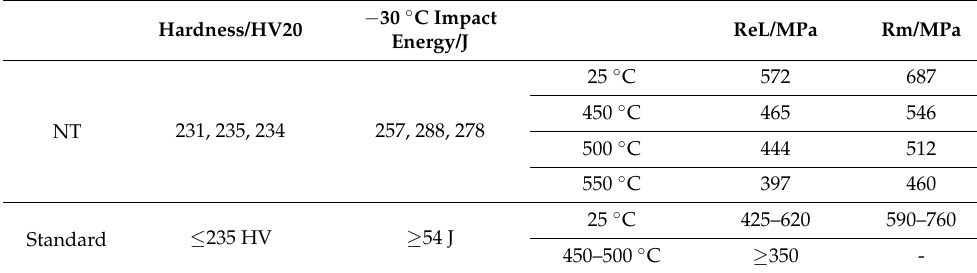
Table 2. Mechanical properties of 2.25Cr1Mo0.25V